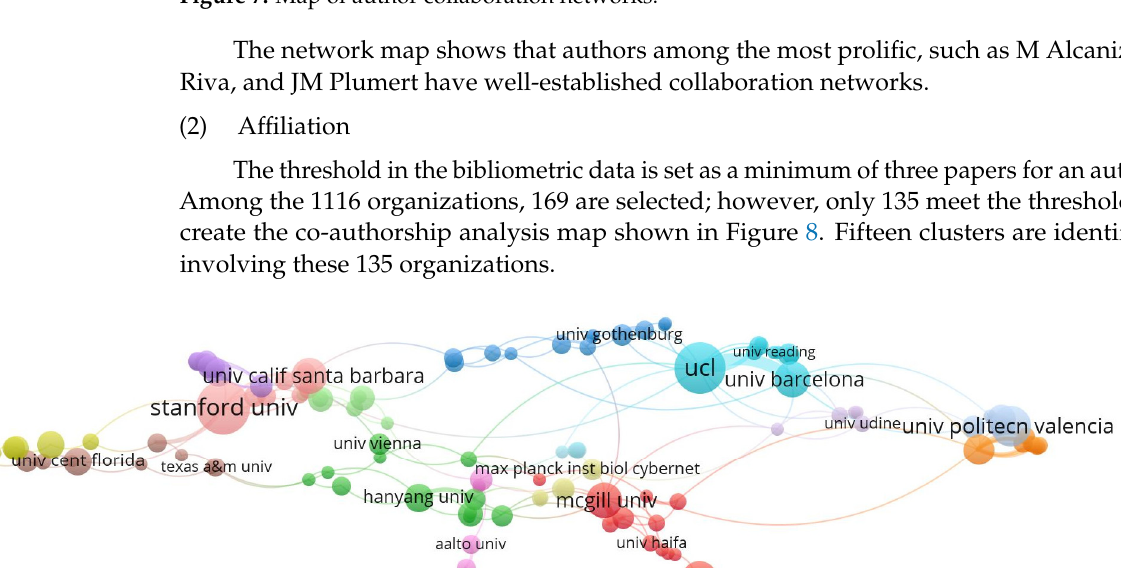
Figure 8. Map of affiliation collaboration networks.